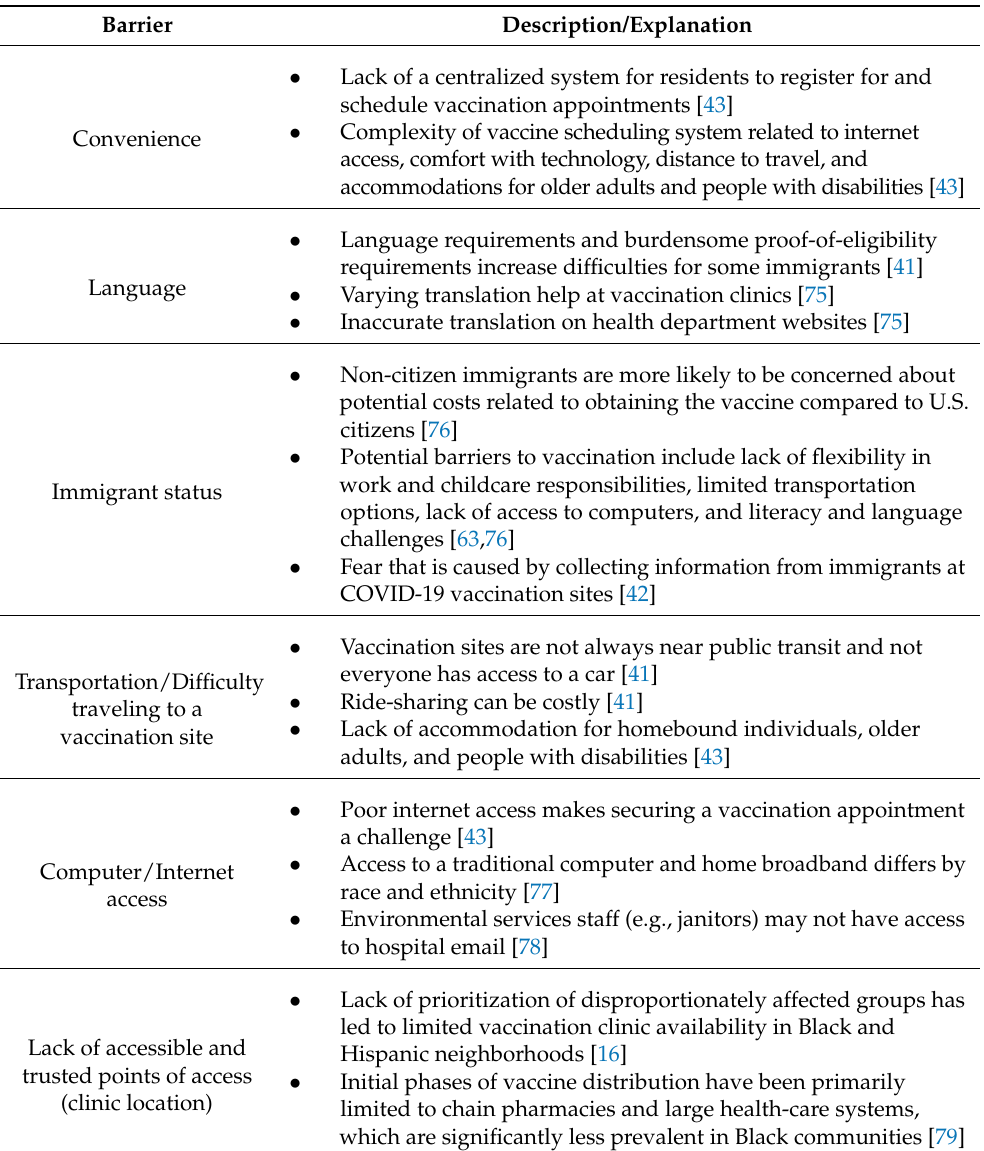
Table 1. Common structural barriers to COVID-19